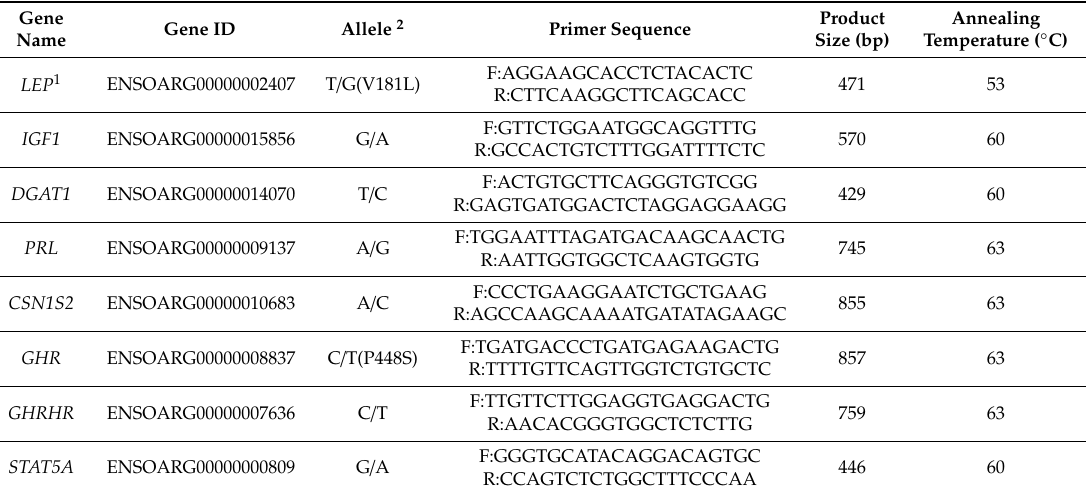
Table 1. Primer pairs of the studied candidate